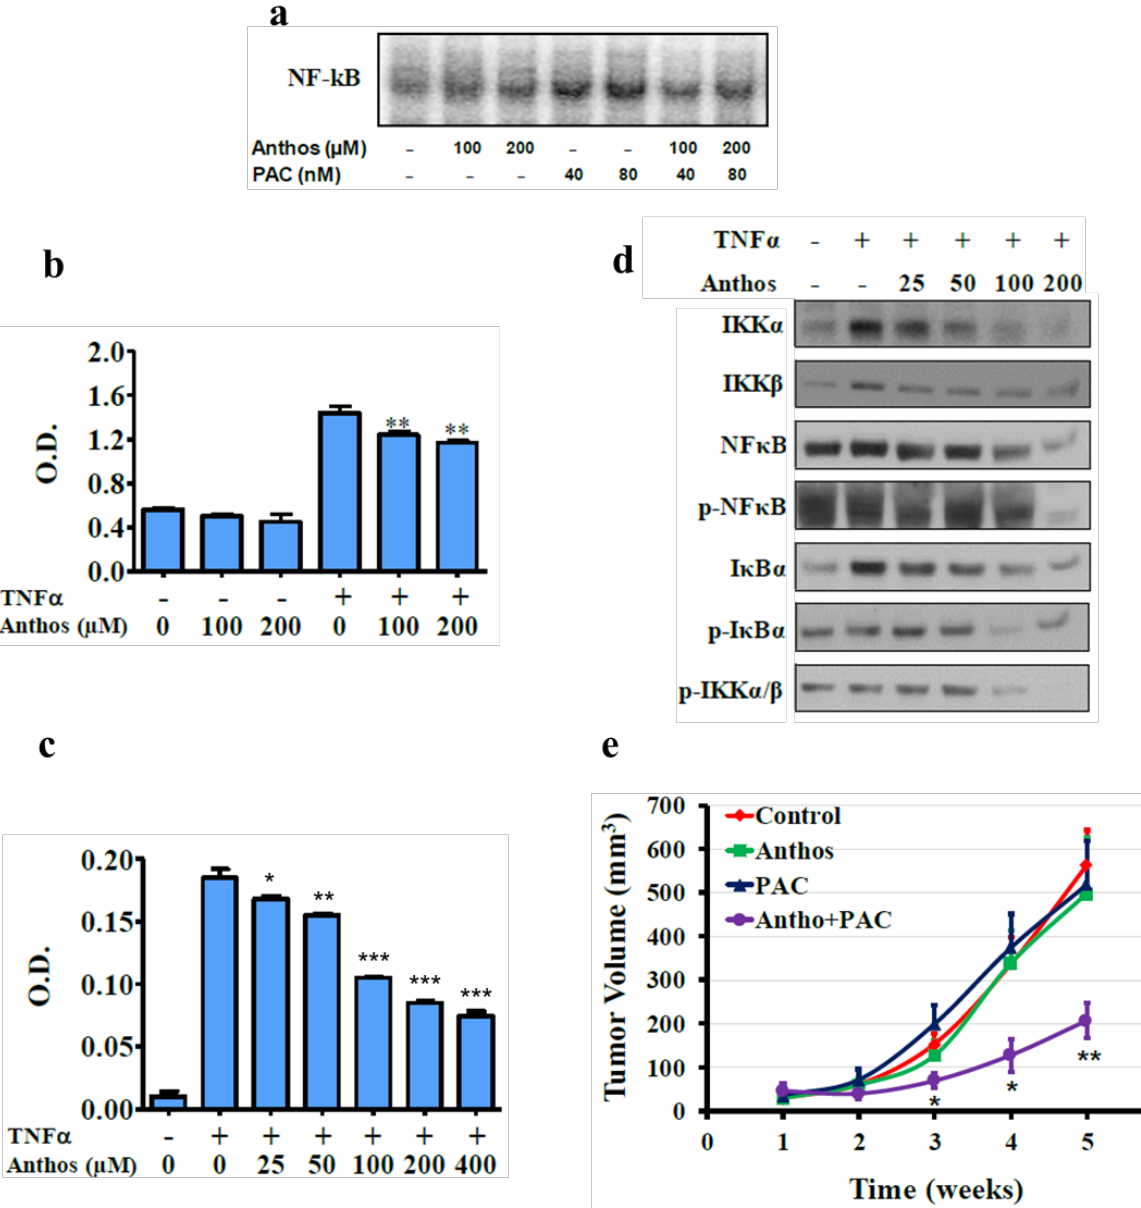
Figure 6. Effect of Anthos on NF- κ B activation, NF- κ B pathway proteins, and tumor growth inhibition of PAC-resistant BC cells: ( a ) MDA-MB-231Tx cells were treated with Anthos and PAC, alone and in combination, for 48 h and nuclear extracts were analyzed by EMSA; ( b ) BC cells were treated with Anthos (100 and 200 µ M) in presence or absence of TNF- α for 48 h and nuclear extracts were analyzed by ELISA; ( c ) Whole-cell lysates were prepared and immune-precipitated with anti-IKK β antibody. The immuno-complex kinase assay was performed by ELISA using CycLex ® IKK α and β Kinase Assay/Inhibitor Screening Kit; ( d ) BC cells were treated with Anthos (0–200 µ M) for 48 h. Whole-cell lysates were probed